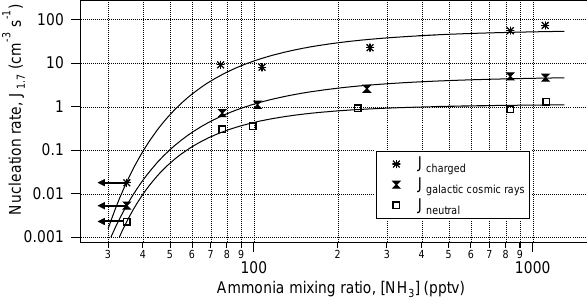
Fig. 6. Nucleation rates as a function of ammonia concentration at 292K and [H 2 SO 4 ]=1.2 × 10 8 cm − 3 (adapted from Kirkby et al., 2011). The curves are drawn to guide the eye. Experiments were performed under neutral, galactic cosmic rays and charged pion beam conditions, corresponding to ion-pair concentrations of about 0, 400 and 3000cm − 3 ,